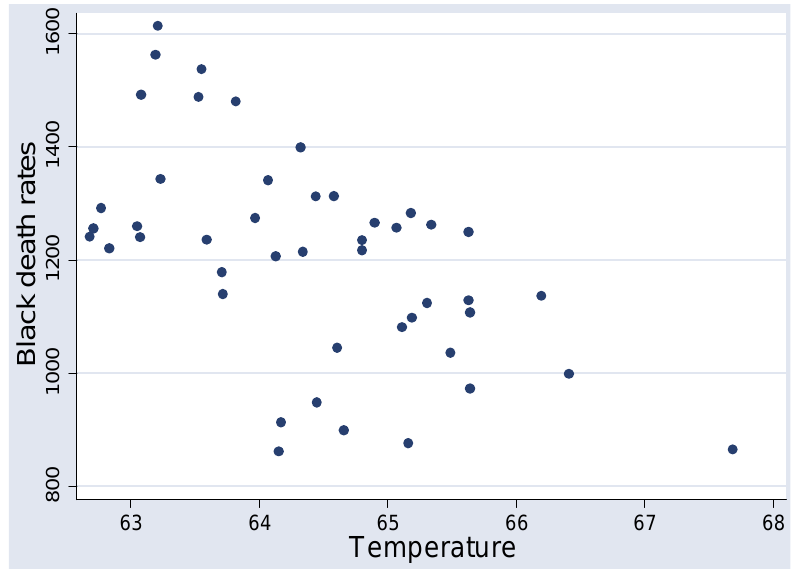
Figure 3. Yearly temperature vs. yearly black age-adjusted death rates in the continental U.S., 1968–2013.